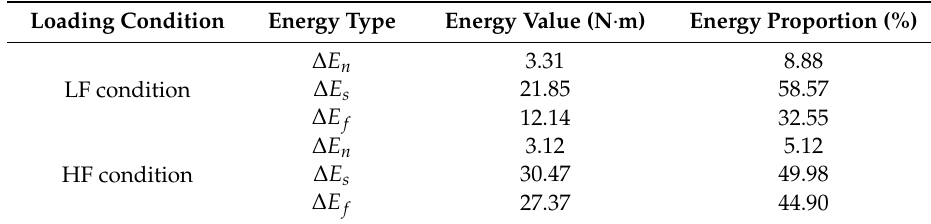
Table 2. Energy increments and proportion of the concrete specimen in different loading condition at the pre-peak stage.